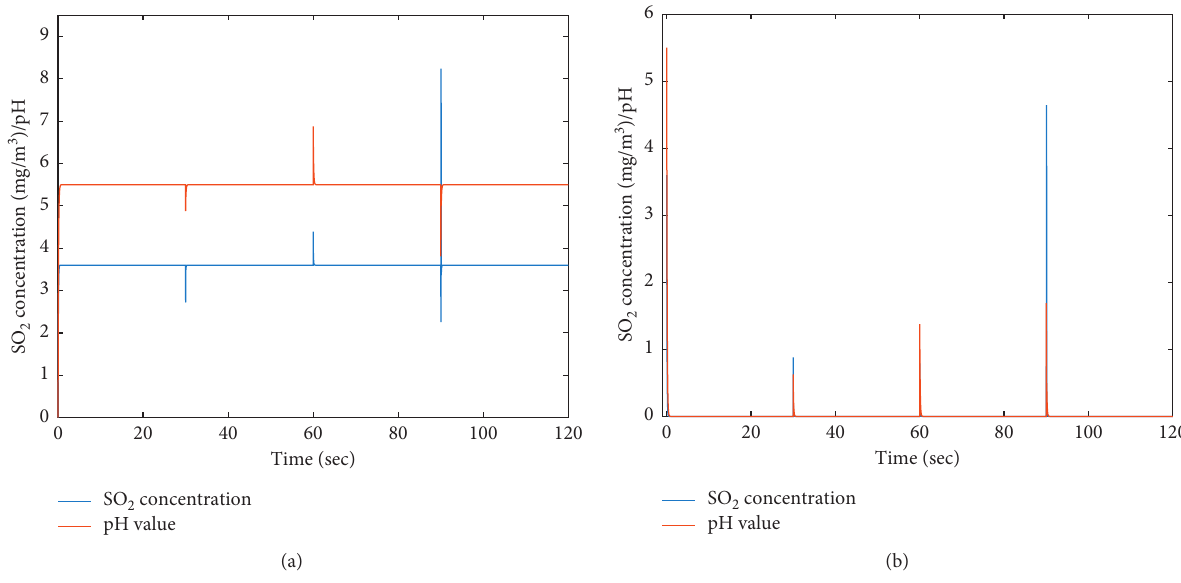
Figure 12: Control response of Case 3: (a) system outputs; (b) absolute value of the control error.